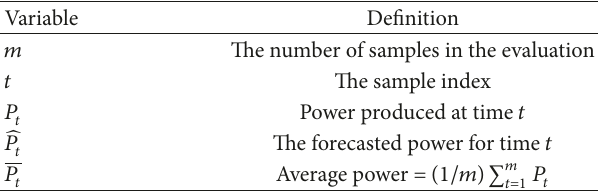
Table 1: A glossary of variables used in ANN error